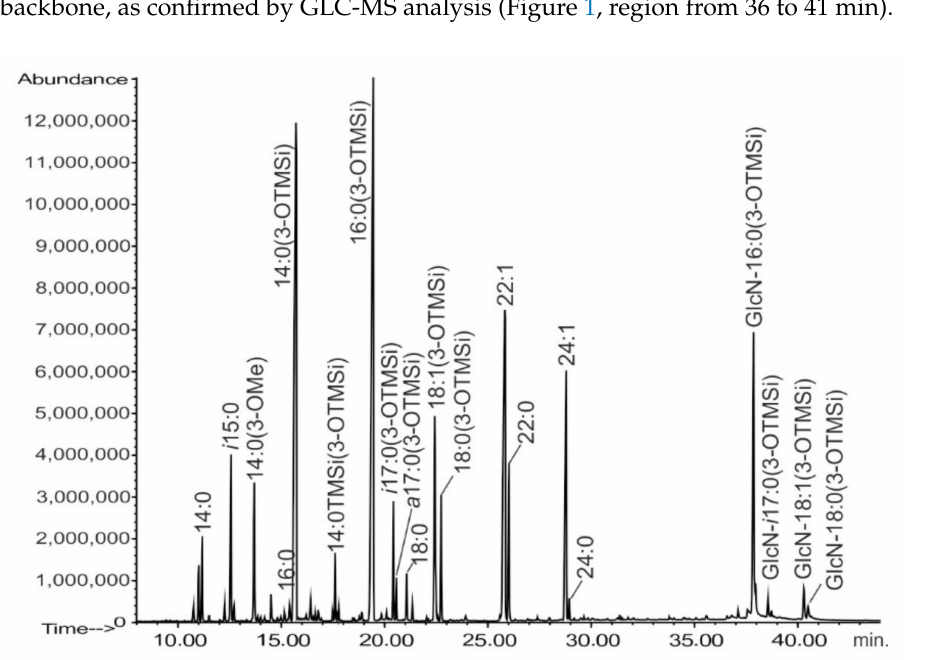
Figure 1. Chromatogram (total ion current) of fatty acids (trimethylsilyl (TMSi) derivatives of methyl esters) from Rv lipopolysaccharide (LPS) (2 M HCl/methanol, 85 ◦ C, 18 h; TMSi). At retention time 37.86 min, 38.56 min, 40.30 min, and 40.45 min. N -[(3-OH)-acyl]-Glc p N derivatives are marked. Unmarked signals were considered to be